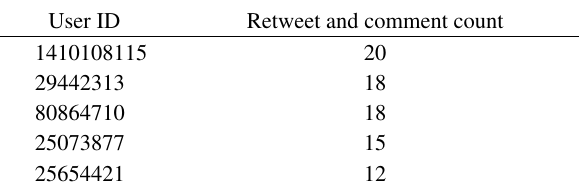
Table 8 Effectiveness of identification of influential spreaders in related